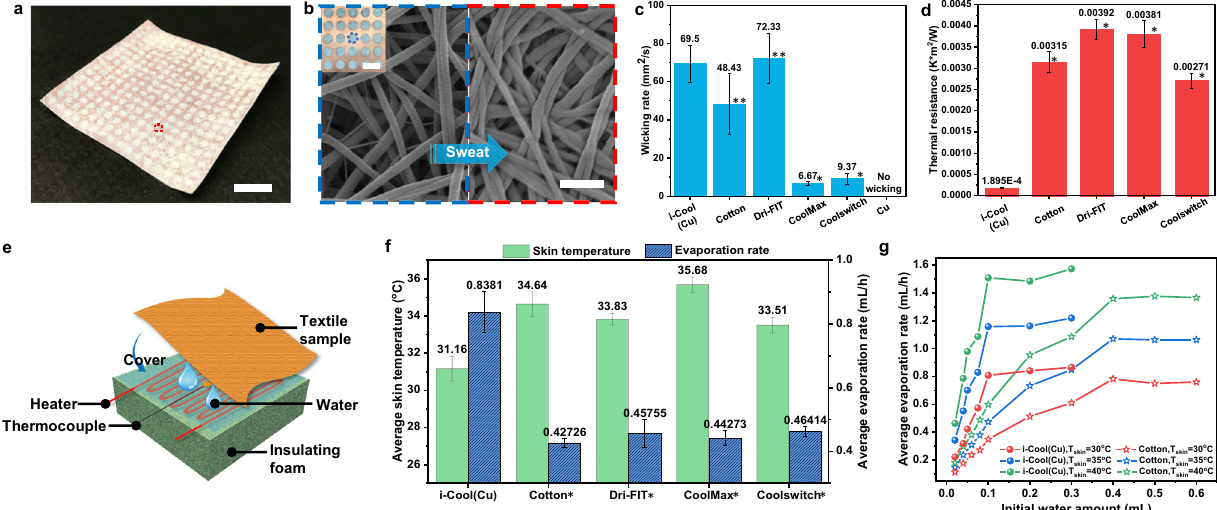
Fig. 2 Wicking performance, thermal resistance and transient droplet evaporation test of the i-Cool (Cu) textile. a , Photograph of as-prepared i-Cool (Cu) textile. Scale bar, 1 cm. b , SEM image of nylon 6 nano fi bres in the pores of heat conductive matrix (blue dash box) and on the top of heat conductive matrix skeleton (red dash box). Sweat tends to be transported to the nano fi bres on the heat conductive matrix skeleton due to the morphology difference. Scale bar, 1 µ m. Inset is the magni fi ed photograph of the bottom side of i-Cool (Cu) textile showing its integrated heat conduction channels and water transport channels. The holes are 2 mm in diameter and 3 mm pitch. Scale bar, 4 mm. c , Wicking rate of the i-Cool (Cu), cotton and other commercial textiles. It shows how fast water underneath the textile can be pulled up and spread on the top surface. Double asterisks, Statistical signi fi cance between the i-Cool (Cu) and labeled sample, Welch ’ s t -test p < 0.1; Asterisk, Statistical signi fi cance between the i-Cool (Cu) and labeled sample, Welch ’ s t -test p < 0.001. d , Thermal resistance of the i-Cool (Cu), cotton and other commercial textiles measured by cut-bar method (See more discussion in Supplementary Note 2). Asterisk, Statistical signi fi cance between the i-Cool (Cu) and labeled sample, Welch ’ s t -test p < 0.001. e , Schematic illustration of the transient droplet evaporation test. f , Average skin temperature and average evaporation rate of the i-Cool (Cu) textile and the conventional textiles (initial water amount: 0.1 mL, skin heater power density: 422.5 W/m 2 ). Asterisk, Statistical signi fi cance of average skin temperature between the i-Cool (Cu) textile and other textile samples, Welch ’ s t -test p < 0.001. Statistical signi fi cance of average evaporation rate between the i- Cool (Cu) textile and other textile samples, Welch ’ s test p < 0.001 . g , Fitted average evaporation rate of i-Cool (Cu) and cotton versus initial water amount at different skin temperature. All the error bars represent standard deviation of measured